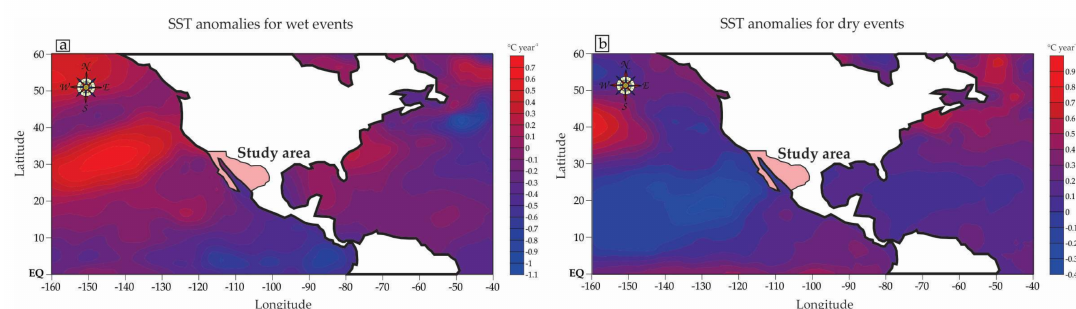
Figure 7. Seasonal average anomalies of the sea surface temperature (SST) for: ( a ) wet extreme years ( ◦ C year − 1 ) and ( b ) dry extreme years ( ◦ C year − 1 ). Source: Authors, following database (https: